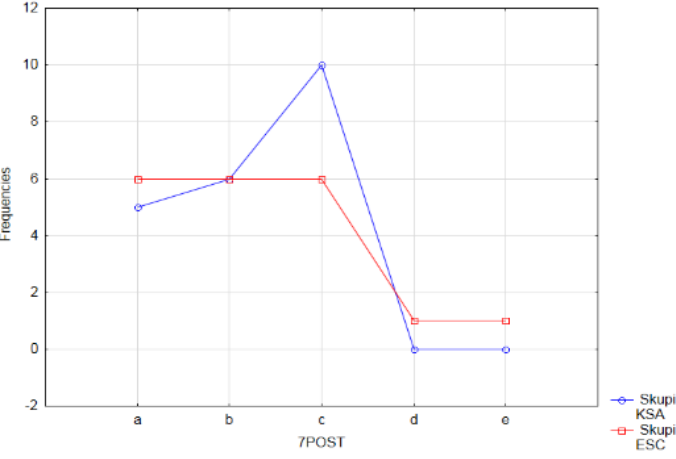
Figure 18. Interaction graph of the sixth item of the posttest - 6POST.